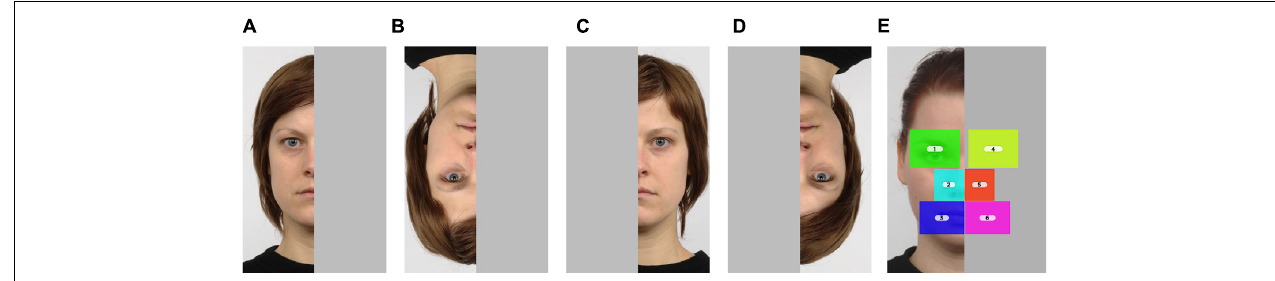
FIGURE 1 | An example of the four stimulus versions presented in the study. (A) Upright – left side visible. (B) Inverted – left side visible. (C) Upright – right side visible. (D) Inverted – right side visible. The fixation data were collected for six areas of interest (AOIs) (E) : (1) eye visible, (2) nose visible, (3) mouth visible, (4) eye covered, (5) nose covered, (6) mouth covered, as well as the out of AOI areas. The images were obtained from the Radboud Faces Database R (cid:13) , with permission (Langner et al., 2010).